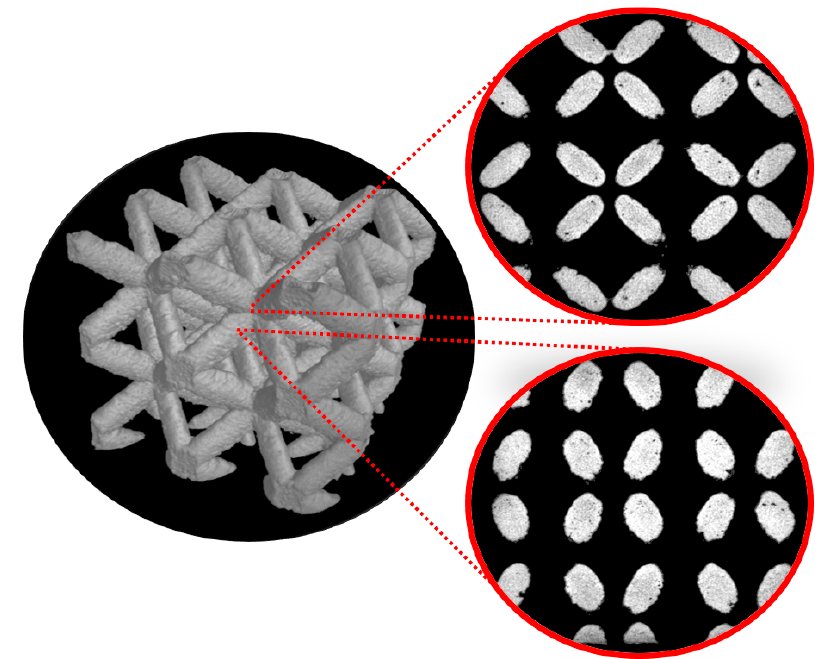
Figure 7. Computed tomography (CT) images of the SLM lattice structure.